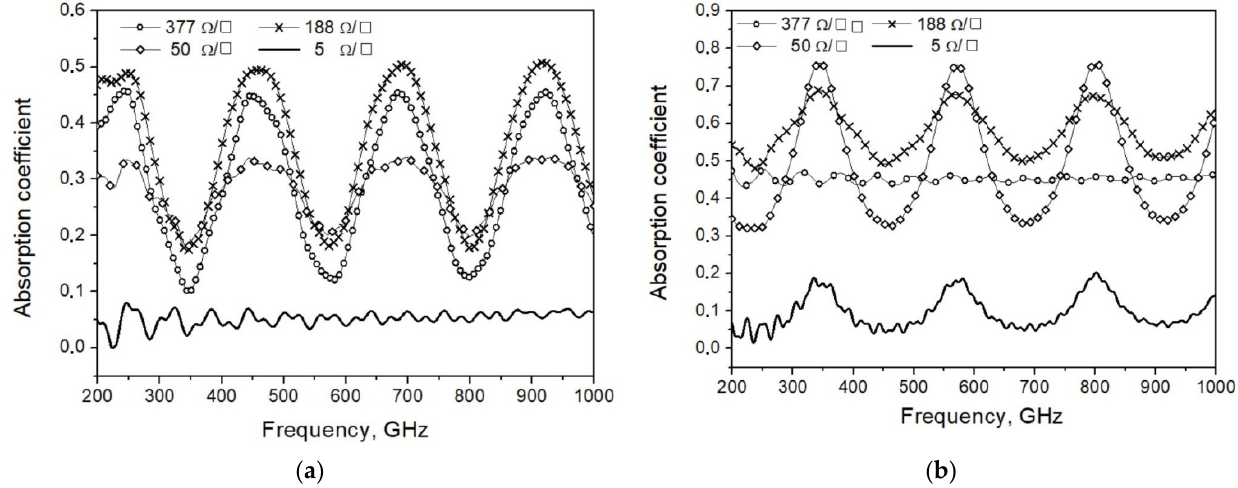
Figure 2. Modeled absorption coefficient for fi lms with di ff erent resistance values ( Ω / □ ): ( a ) irradiation from film side; ( b ) irradiation from substrate side .